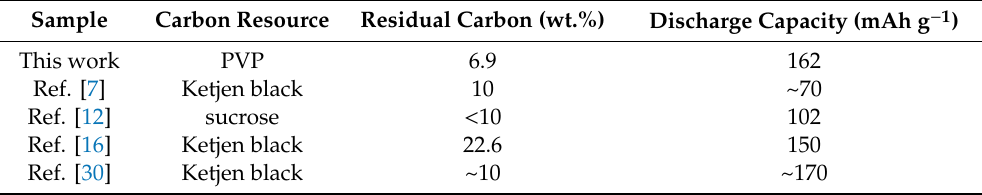
Table 1. Comparison of the discharge capacities of LiMnBO 3 / C at 0.05